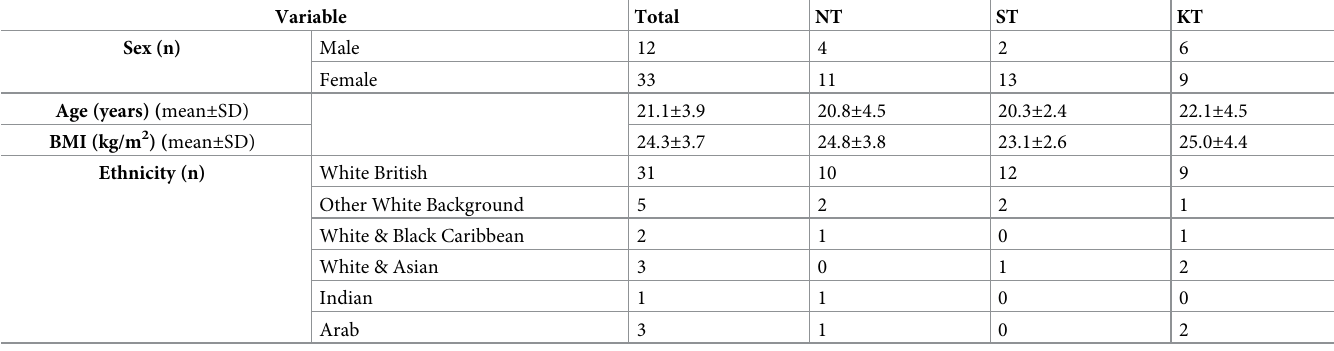
Table 1. Demographic characteristics and anthropometric data of all